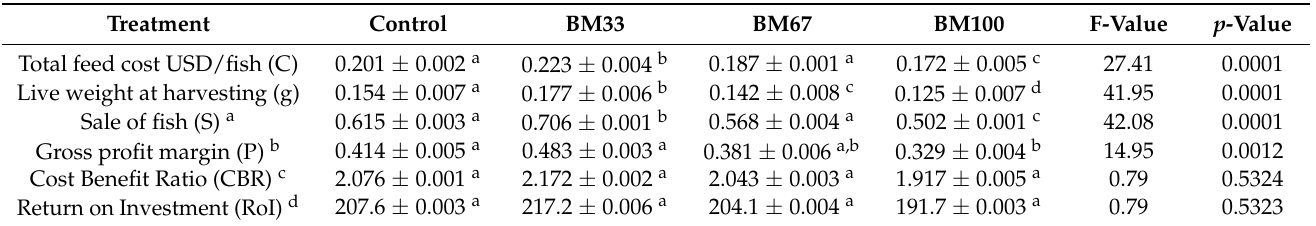
Table 5. Economic analysis (means ± SE) of partial and complete substitution of fishmeal (FM) with black soldier fly larvae meal (BM) in Nile tilapia pelletized